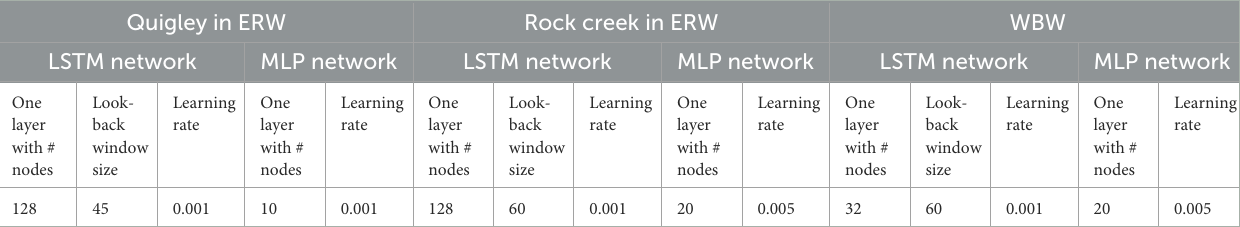
TABLE 1 The network model structures and their learning parameters used in streamflow prediction and UQ for both watersheds ERW and WBW. Quigley in